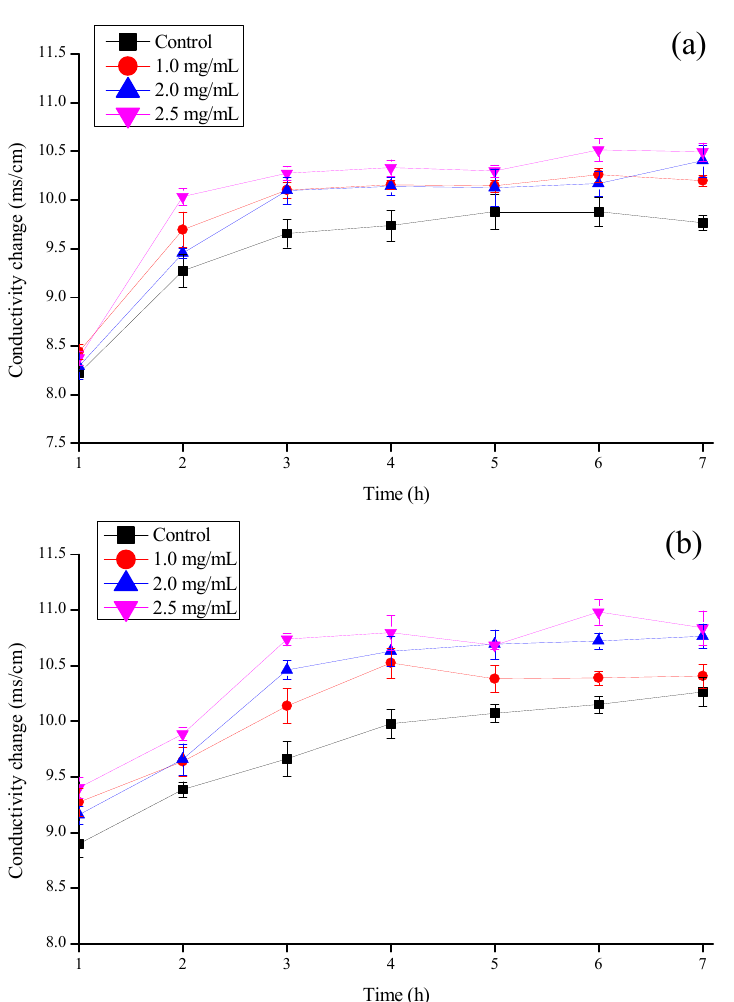
Figure 6. Effect of different concentration of CSNP solutions (mg/mL) on the extracellular conduc- tivity of ( a ) P. steckii and ( b ) A. oryzae after 1, 2, 3, 4, 5, 6, and 7 h of incubation.